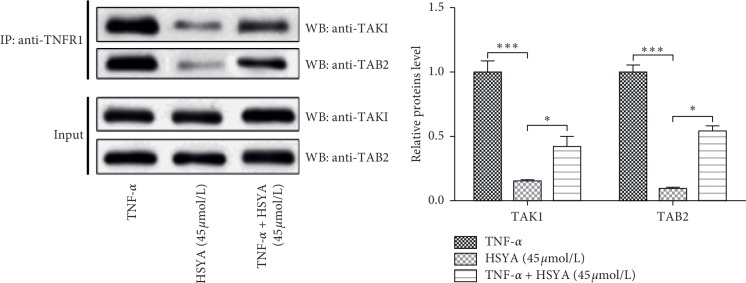
HSYA inhibits the binding of TNFR1 and TAK1-TAB2 complexes in TNF-α induced MRC-5 cells. Note: western blot results manifested that TNFR1 can bind with TAK1 and TAB2 proteins; HSYA, hydroxysafflor yellow A; ∗P < 0.05; ∗∗∗P < 0.01.